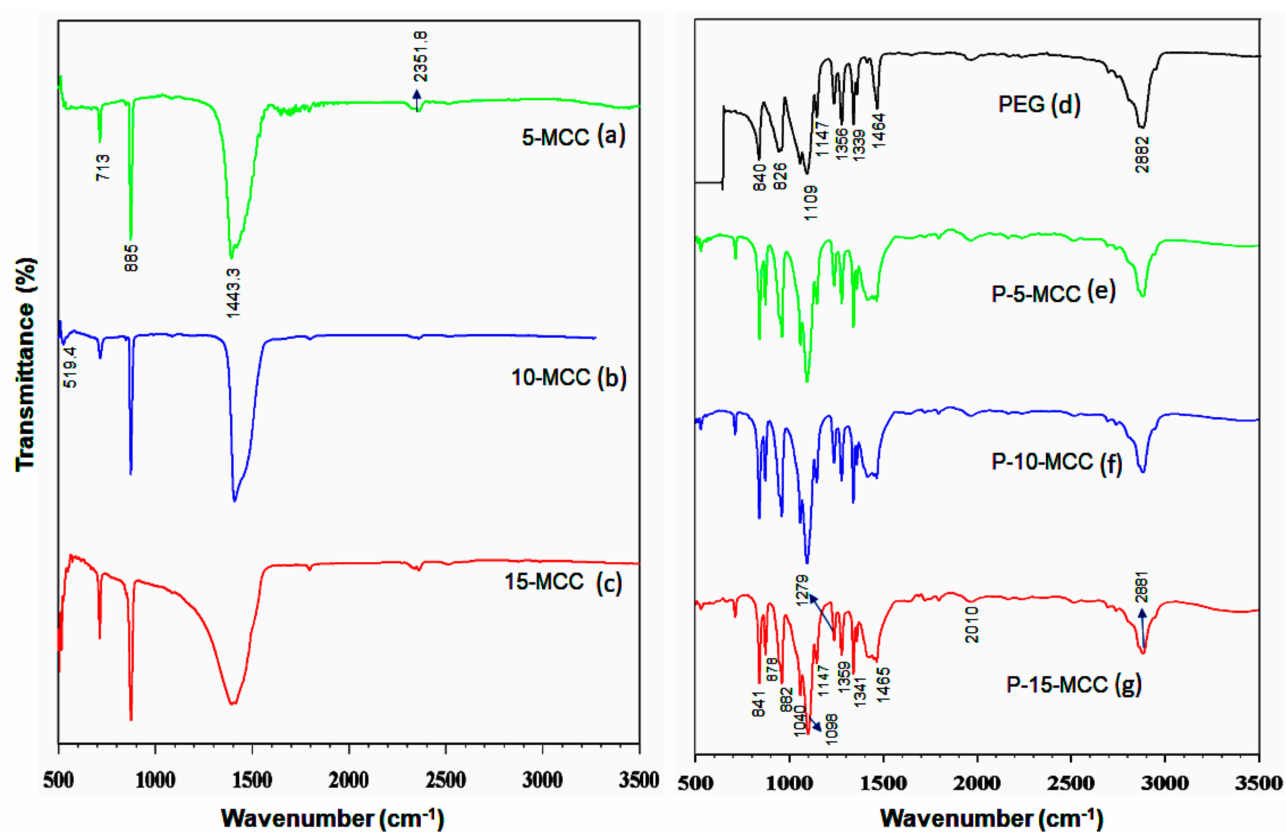
Figure 2. FTIR spectra of ( a ) 5-MCC, ( b ) 10-MCC, ( c ) 15-MCC, ( d ) PEG-6000, ( e ) P-5-MCC ( f ) P-10-MCC, and ( g ) P-15-MCC